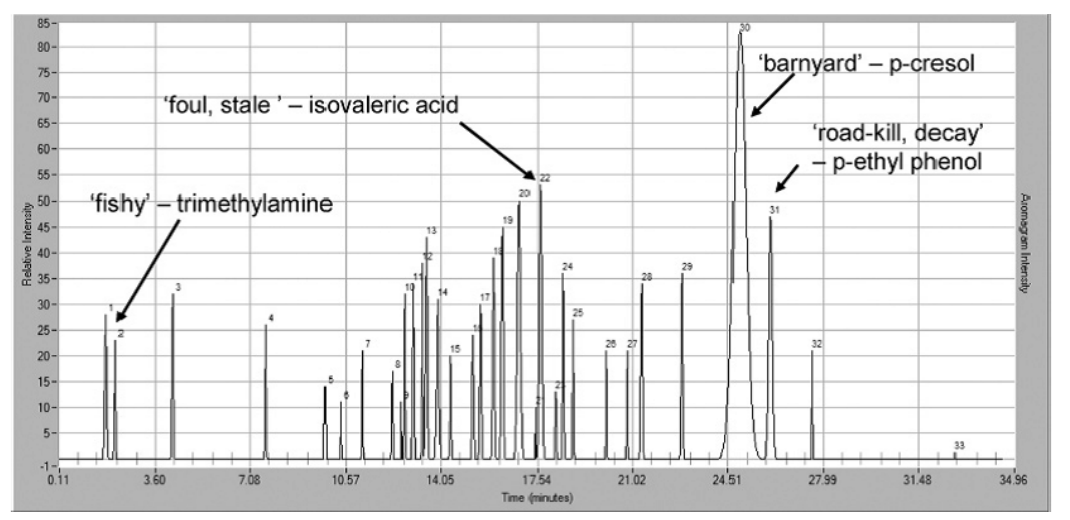
Figure 9. Aromagram for 4 h SPME fiber collection 20 m downwind (―near‖ site) from commercial beef cattle feed yard (reprinted from [193] with permission from Elsevier).